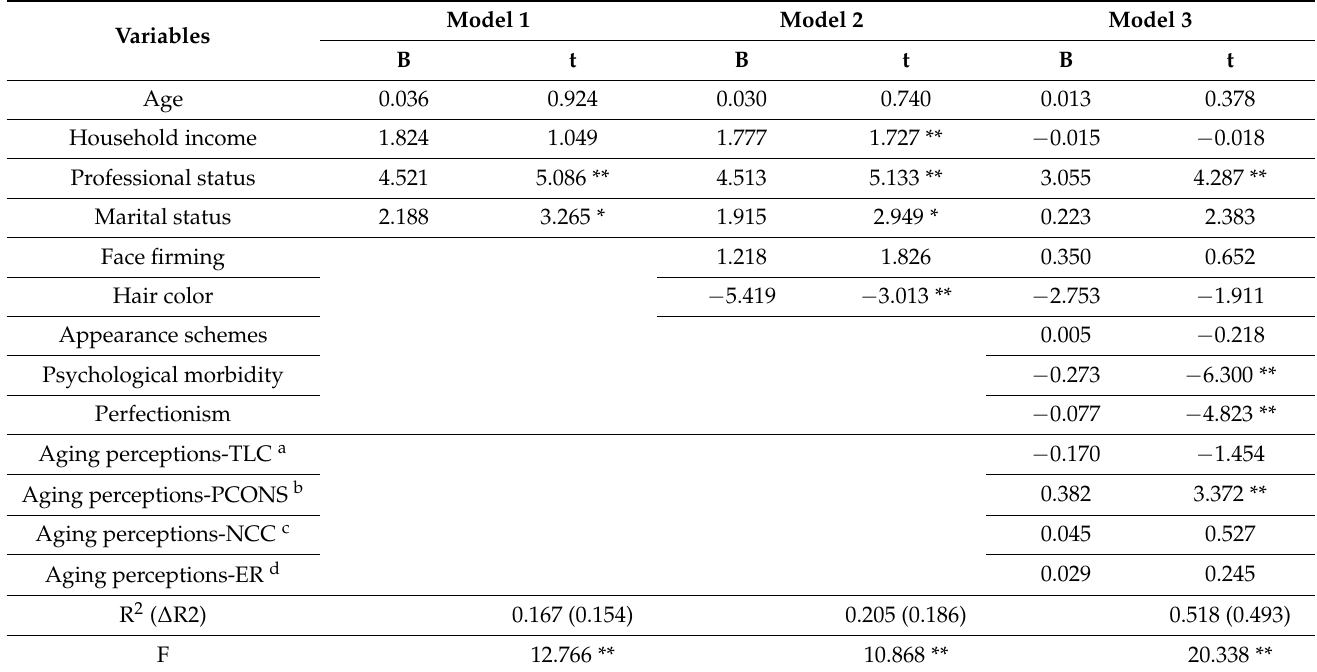
Table 5. Variables that contribute to